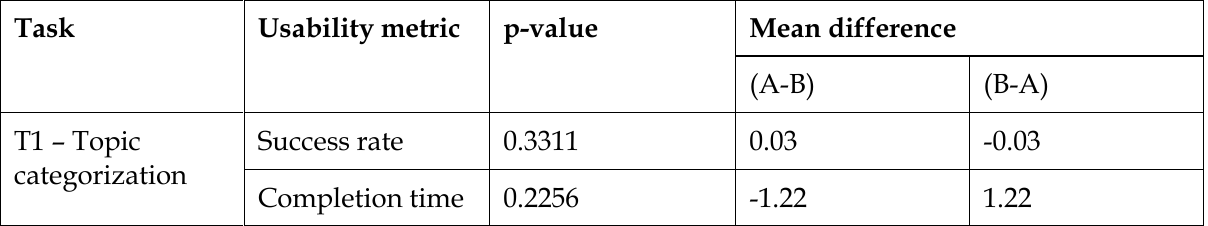
Table 3: p-values when applying the pairwise comparison to the two-way repeated measures ANOVA test with Bonferroni’s correction. *: There are significant differences considering a significance level of 5% and Bonferroni